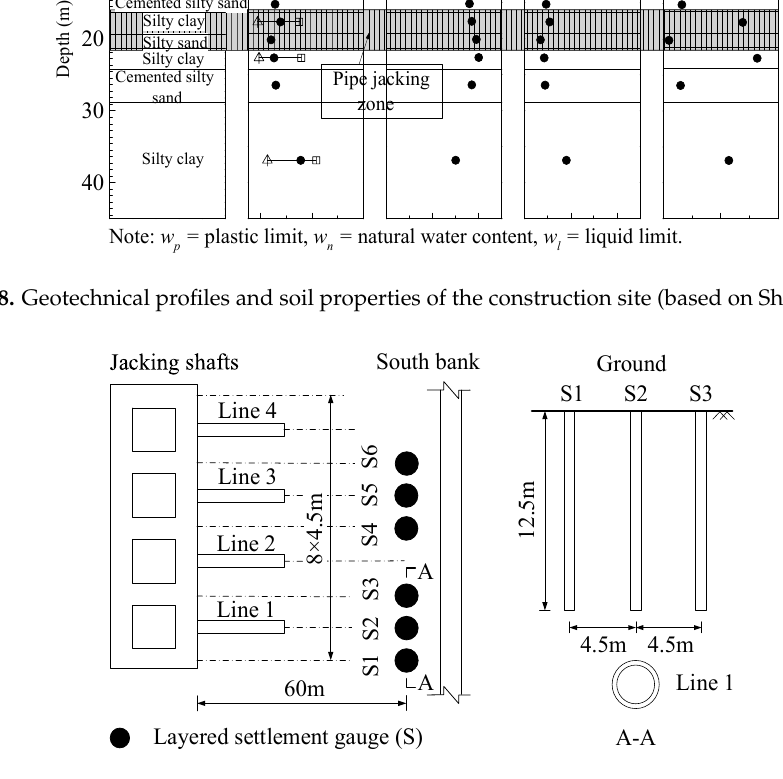
Figure 9. Location and vertical distribution of layered settlement gauges.